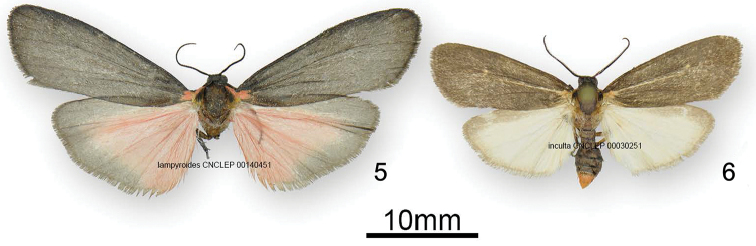
Adult male 5Hypoprepialampyroides and 6Hypoprepiainculta.